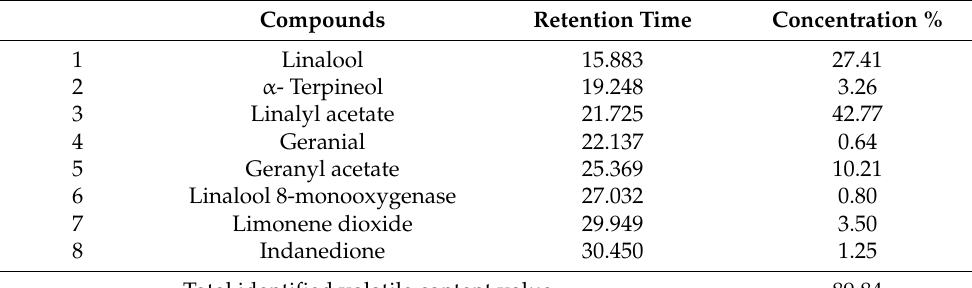
Table 2. Volatile compounds of neroli